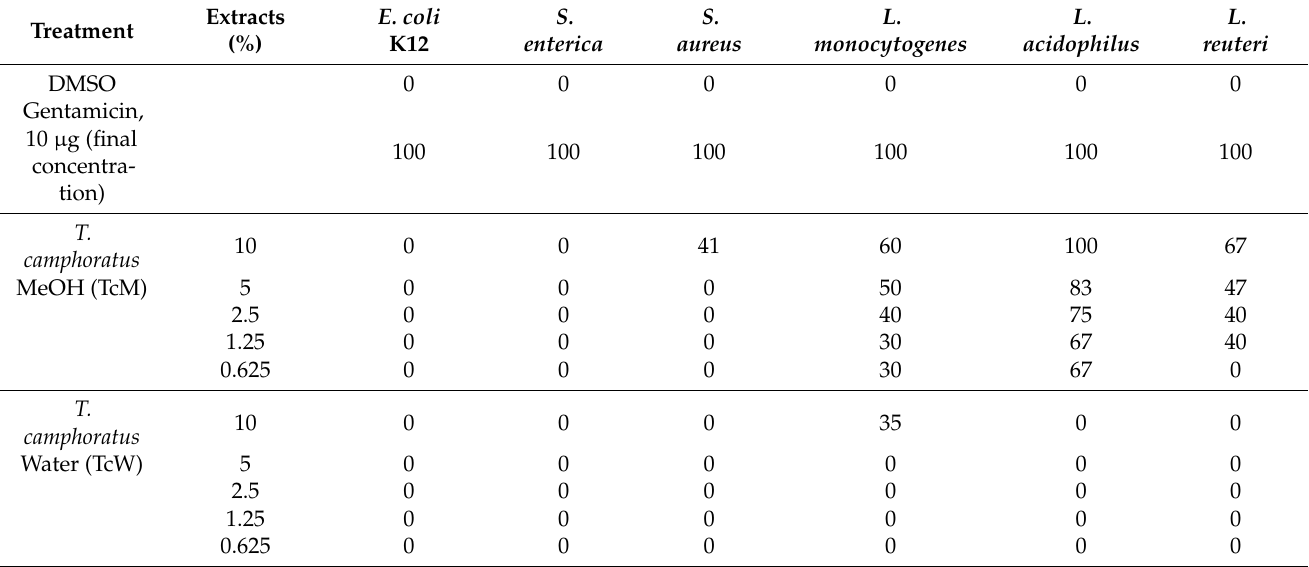
Table 5. Antibacterial activity (% zone of inhibition compared to the Gentamicin control) of T. camphoratus extracts 1